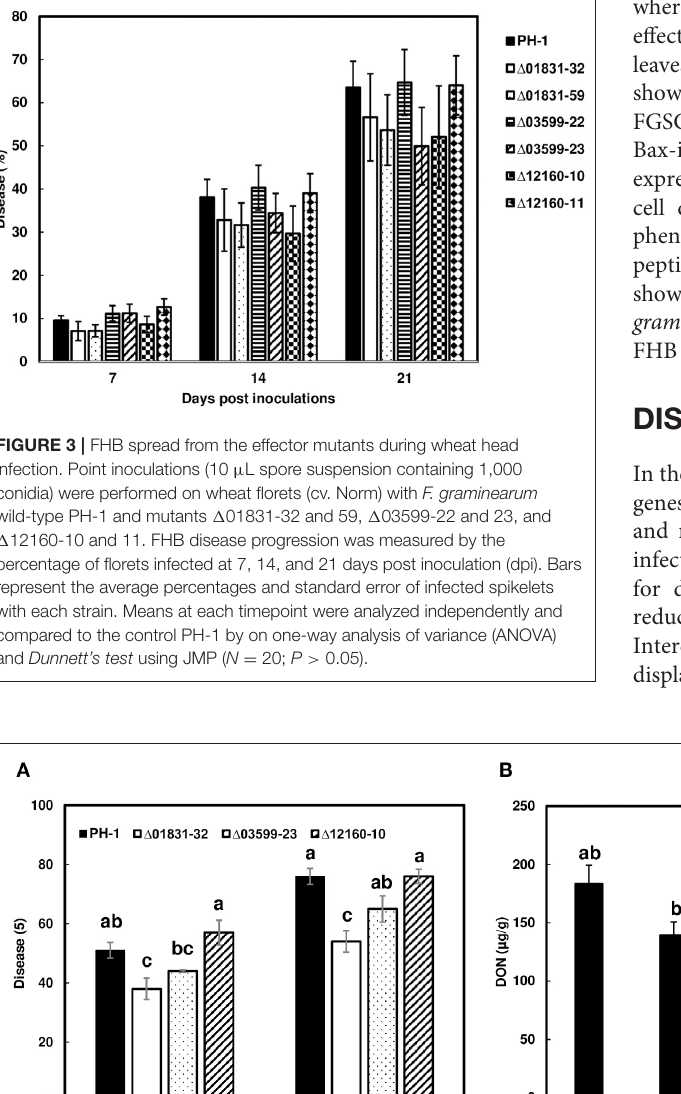
Frontiers in Plant Science |